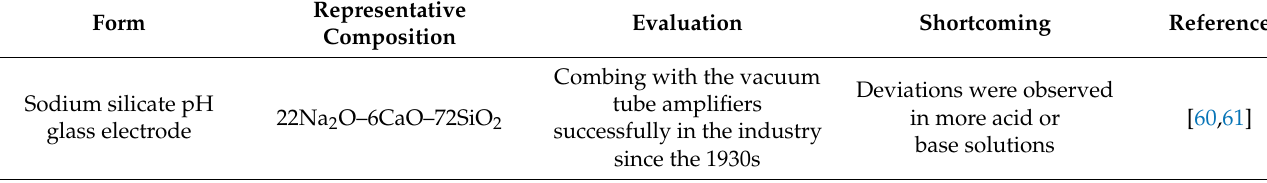
Table 1. The development of glass